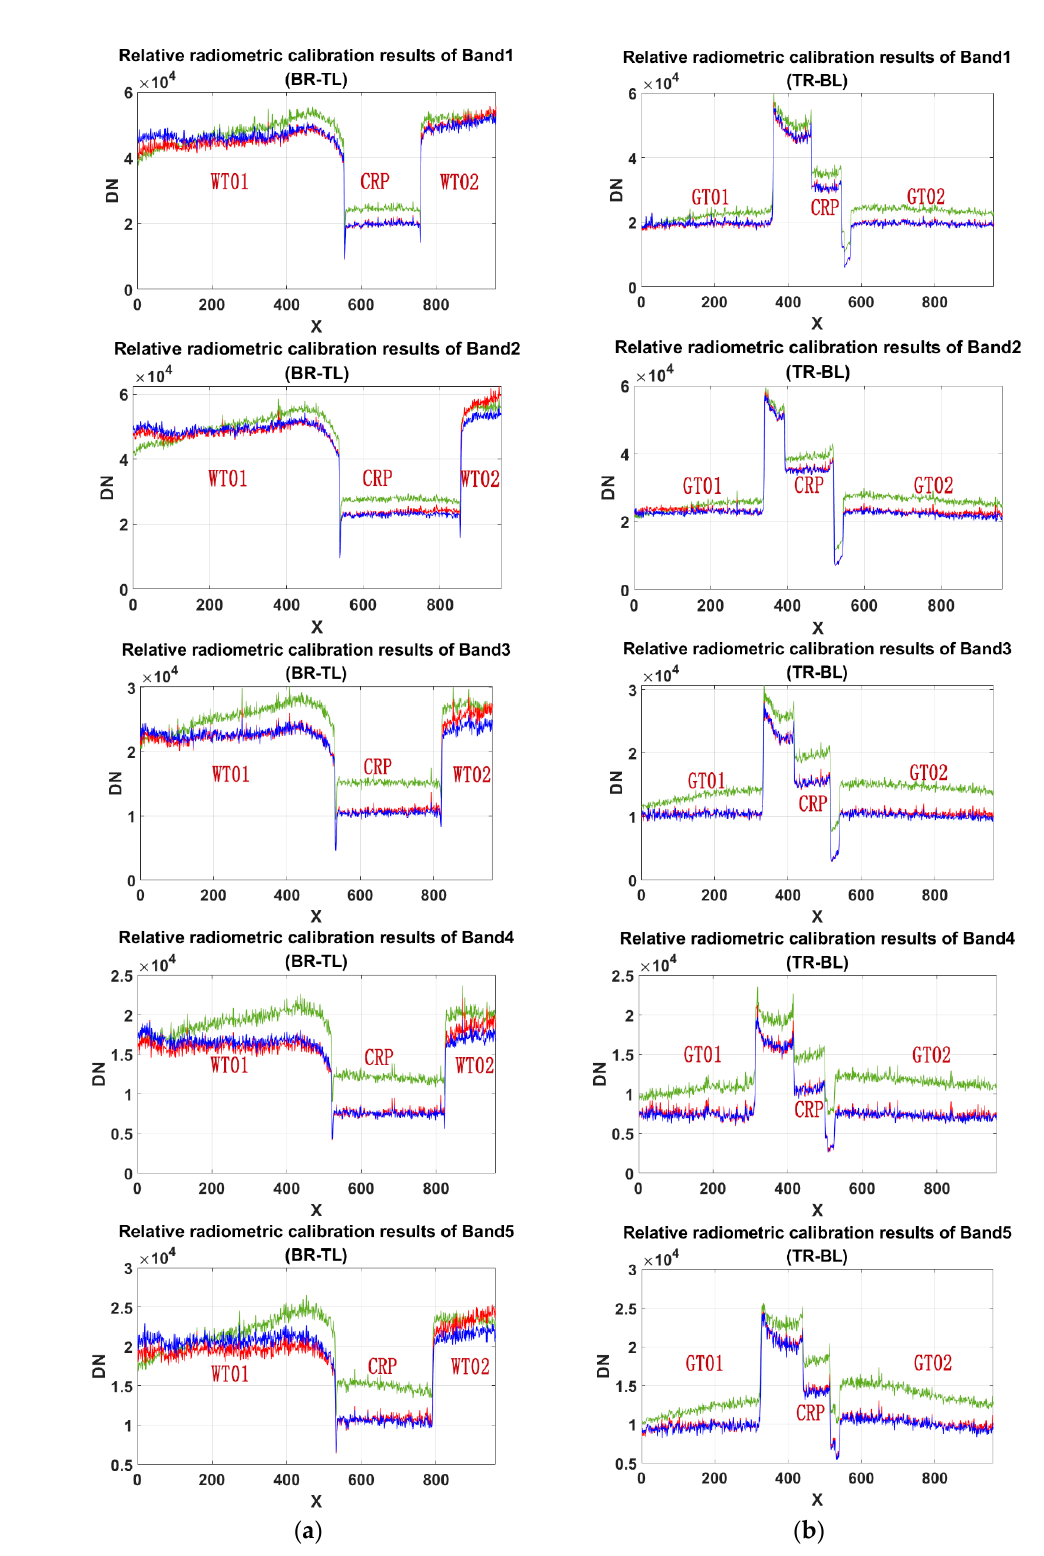
Figure 19. Comparison of diagonal pixels of original images and the images corrected by two methods (green-original images, red-manufacturer’s method, blue-proposed LUT method): ( a ) BR-TL diagonal pixels of five bands; ( b ) TR-BL diagonal pixels of five bands.